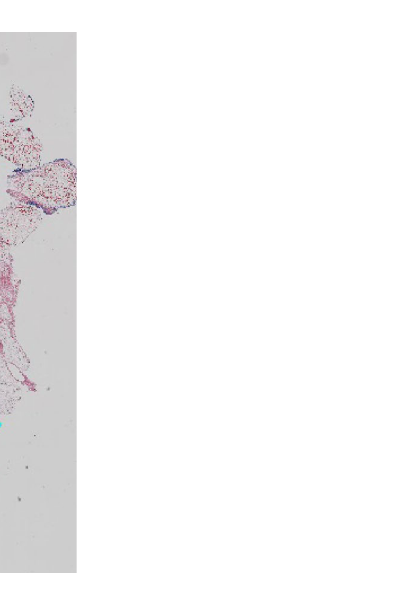
Figure 2. d 1 (turquoise) and d 2 (blue) for the tumor bed convex